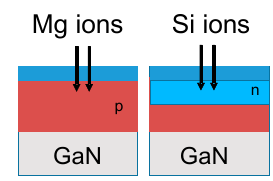
Figure 3. TEM images of double ion implanted layer of Mg and Si: ( a ) as-implanted, ( b ) annealed at 1230 °C. 3. Device Structure and Fabrication A schematic cross section of the device structure of an ion-implanted GaN DMOSFET on a free- standing GaN substrate is shown in Figure 4. The channel regions were fabricated in the Mg ion- implanted layers and the gate length was self-alignedly defined by the difference in the depths between Mg and Si implanted regions. The fabrication process of the DMOSFET is illustrated in Figure 5. The GaN layer (5 μ m) with a Si density of 5 × 10 16 cm − 3 was grown by metal-organic vapor phase epitaxy (MOVPE) on a free-standing GaN substrate with a low threading dislocation density of 10 6 cm − 2 . Mg ions were implanted to form contact regions of the p-base regions at first. Mg ion implantation at a tilt angle of 30° was then carried out to form deep retrograde p-base regions in which channel and n-type source regions were formed. Mg ions were implanted for the left hand- side and right hand-side of the photoresist (OFPR-800, 2 μ m-thick) mask region at three different energies of 200, 100, and 50 keV with doses of 1.0 × 10 14 , 3.2 × 10 13 , and 1.5 × 10 13 cm − 2 (single side total dose: 1.47 × 10 14 cm − 2 ) through 30-nm-thick SiN x film, respectively. The junction field effect transistor